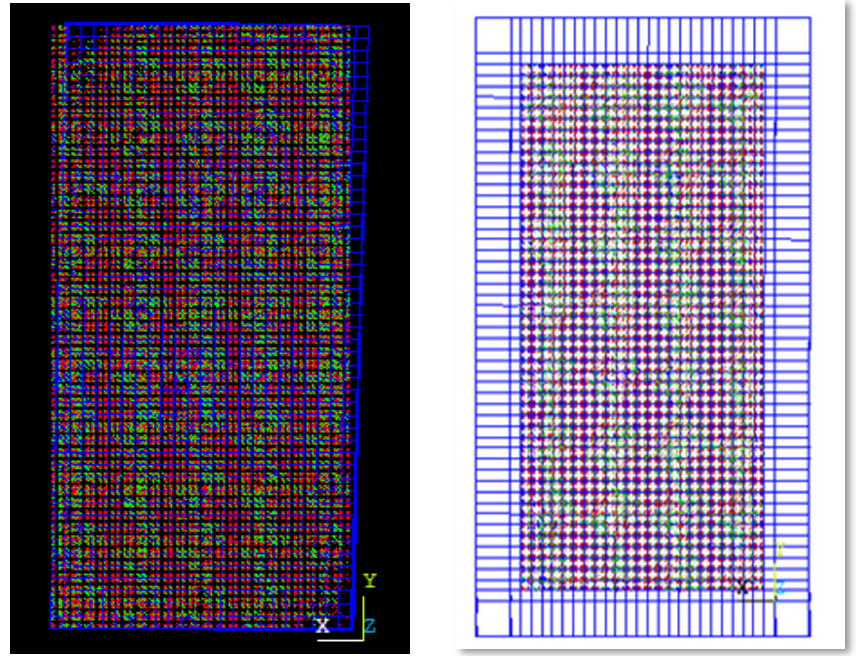
Figure 7. Concrete crack formation for numerical specimen.